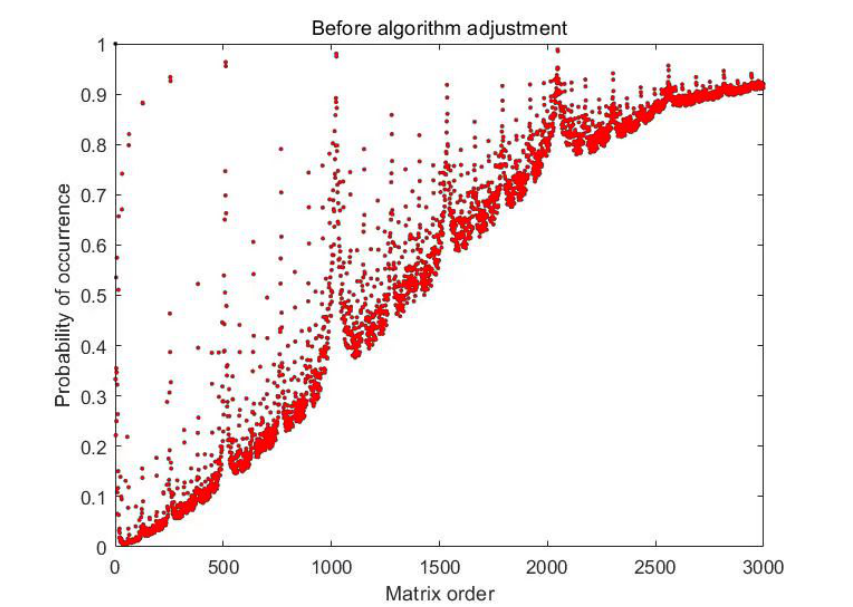
Figure 9. Occurrence probability of the offset sequence in the range of 3000-order matrices, where the horizontal axis is the order of the matrices and the vertical axis is the occurrence probability of the offset sequence in 5000 loops, without Formula